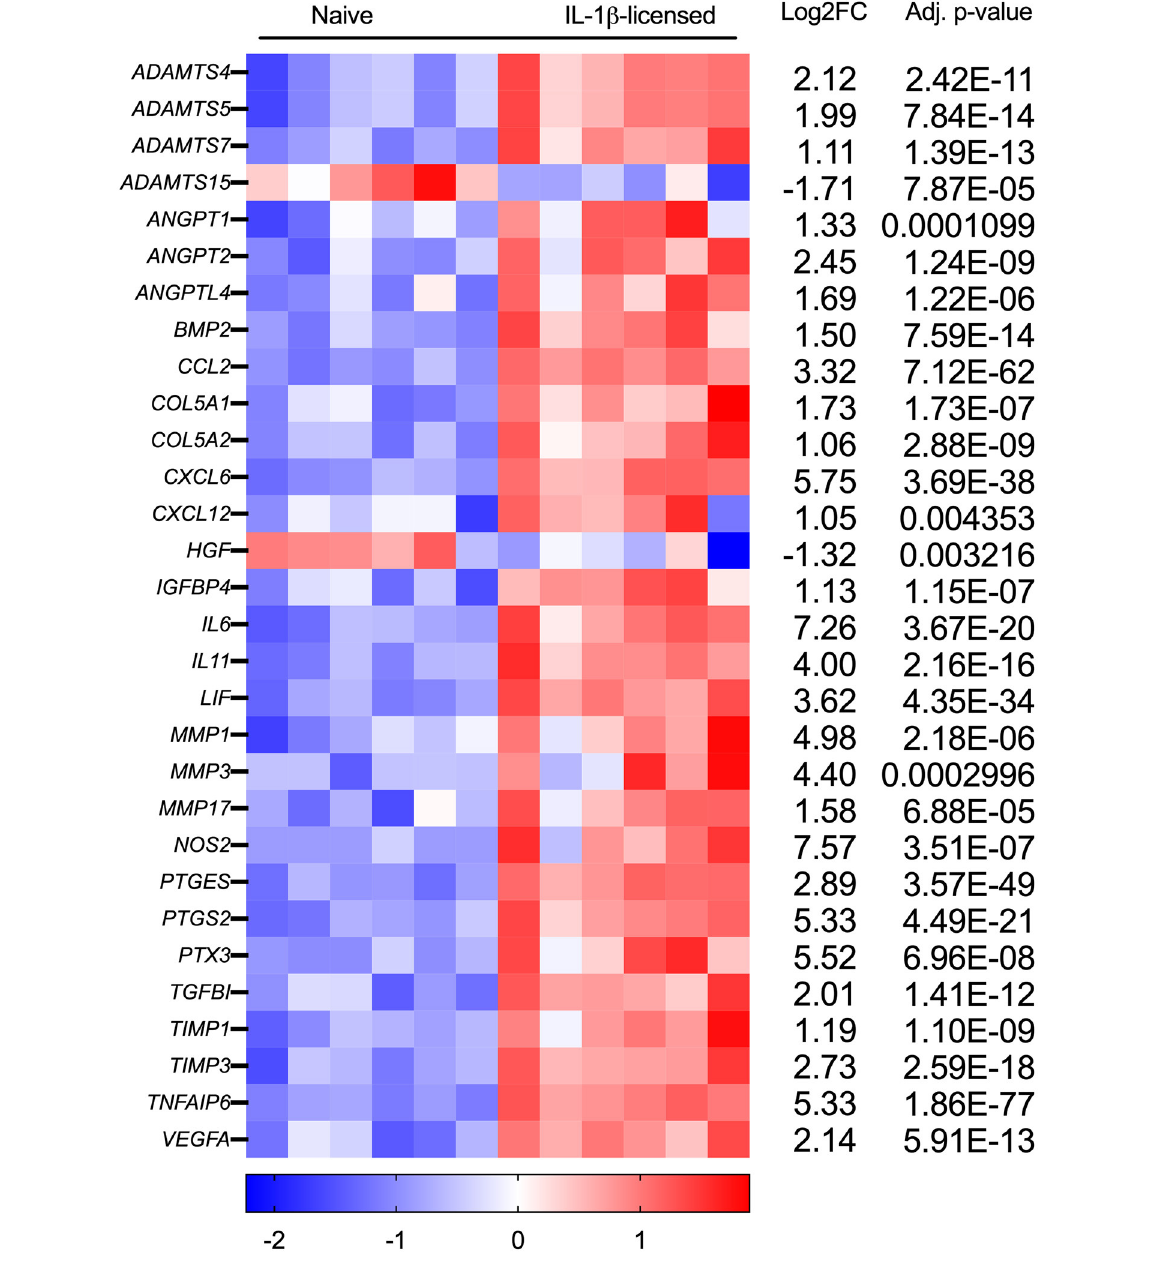
regulated genes were identified, that if translated to their downstream proteins, could have tendon-relevant effects (Table 1) through tendon or MSC-specific function including those associated with vascular development (ANGPT1/2, ANGTPL4, CXCL6, VEGF-A, VEGF-C), synthesis and